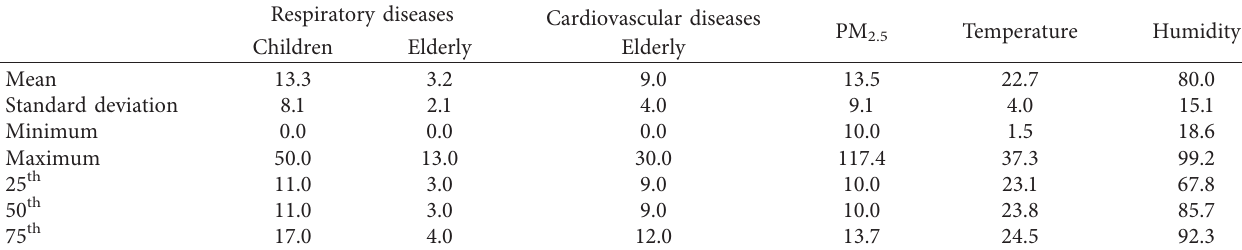
Table 1: Basic descriptive parameters in Manaus, Amazonas, Brazil, from 2008 to 2012.